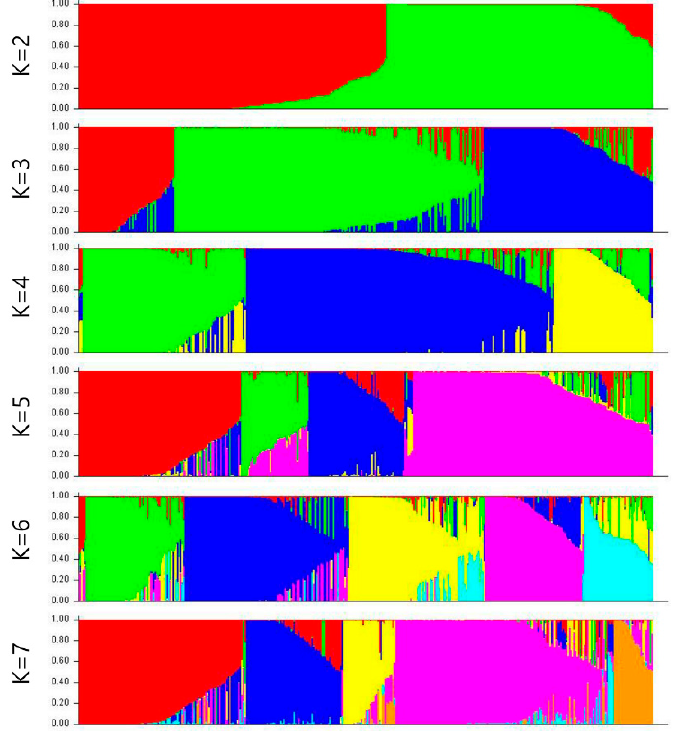
Figure 4. Structure clustering results obtained at K = 2 to K = 7 of the 384 peanut accessions. Each individual is represented by a bar corresponding to the sum of assignment probabilities to the K cluster.